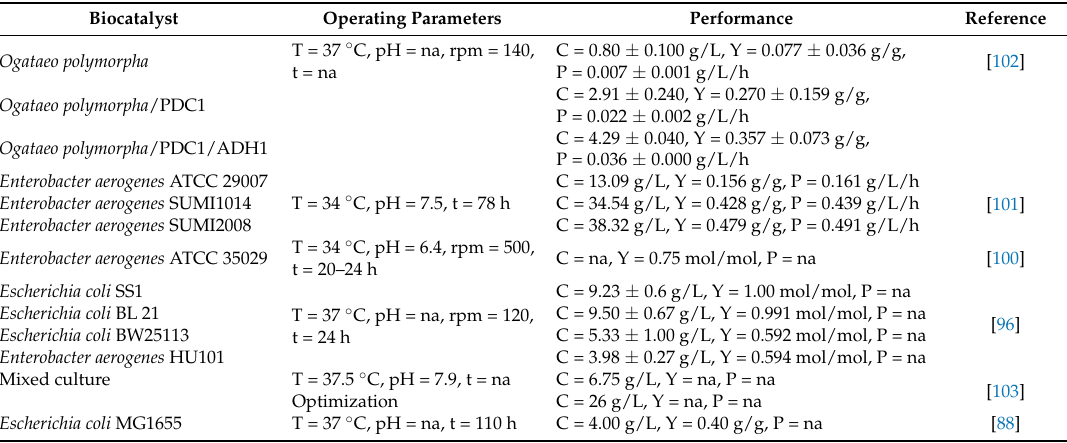
Table 7. Performance of some biocatalysts in the conversion of glycerol to ethanol as reported in some literature. Biocatalyst Operating